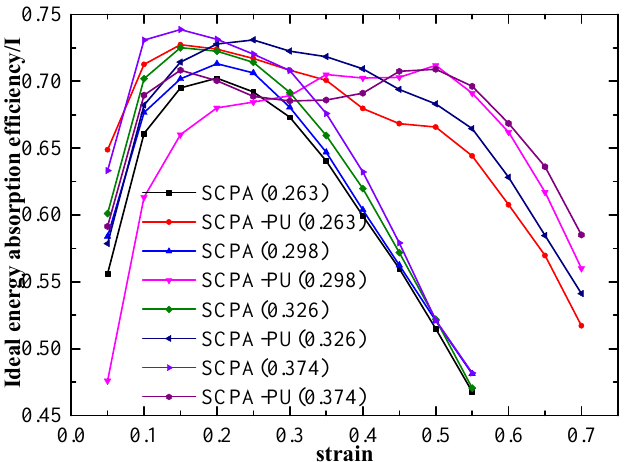
Figure 7.  I curves of the SCPA and the SCPA ‐ PU composites with different relative density values. Figure 7. I − ε curves of the SCPA and the SCPA-PU composites with different relative density